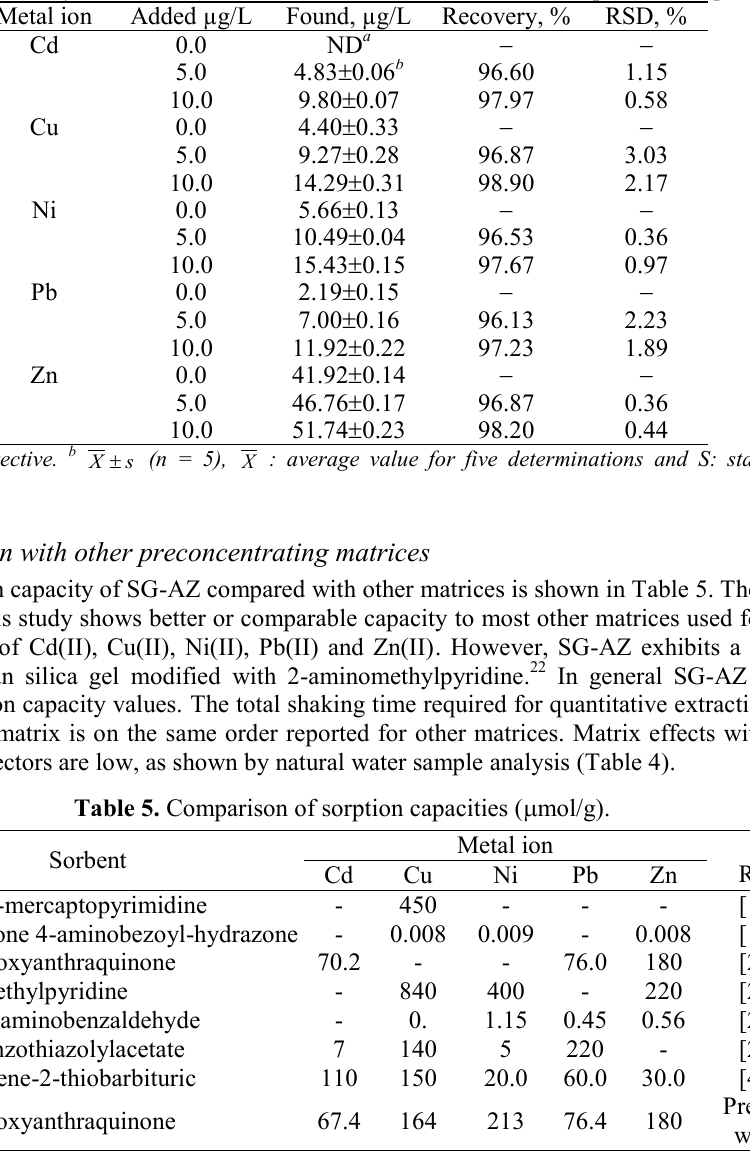
Table 4. Analytical results for the determination of metal ions in tap water samples.